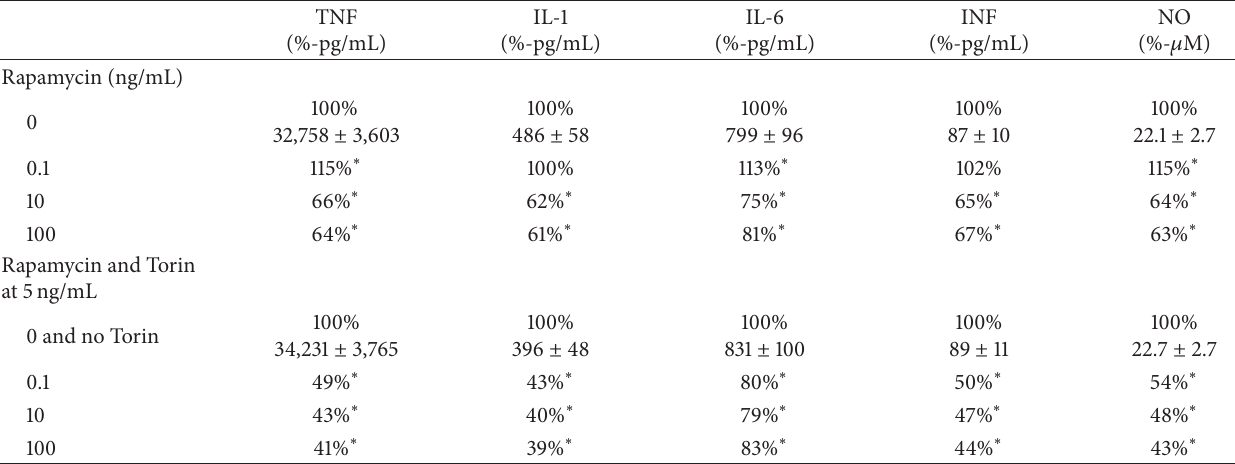
Table 2: The table indicates the reduction from the control of RAW264.7 macrophages inflammatory response in the presence of 0, 0.1, 10, and 100ng/mL Rapamycin (up) and Rapamycin and Torin 5 ng/mL (down).